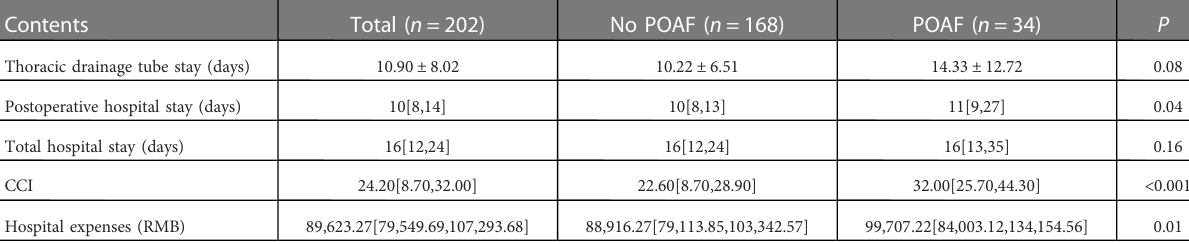
TABLE 2 Comparisons of perioperative outcomes between the POAF group and no POAF